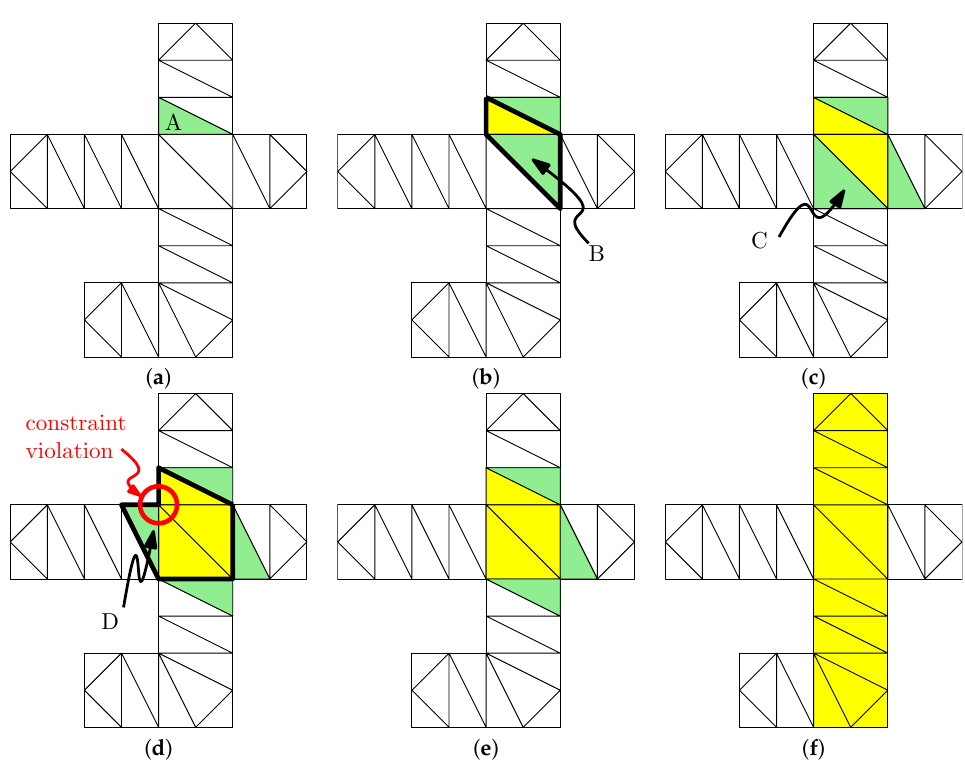
Figure 2. Example of computing the maximal expansionstarting from a seed facet. Yellow facets are the currently expanded region E , green facets are those in the queue. ( a ) Initial state. ( b ) Candidate facets after A is chosen as the seed. ( c ) Candidate facets after B is chosen to expand. ( d ) Choosing D